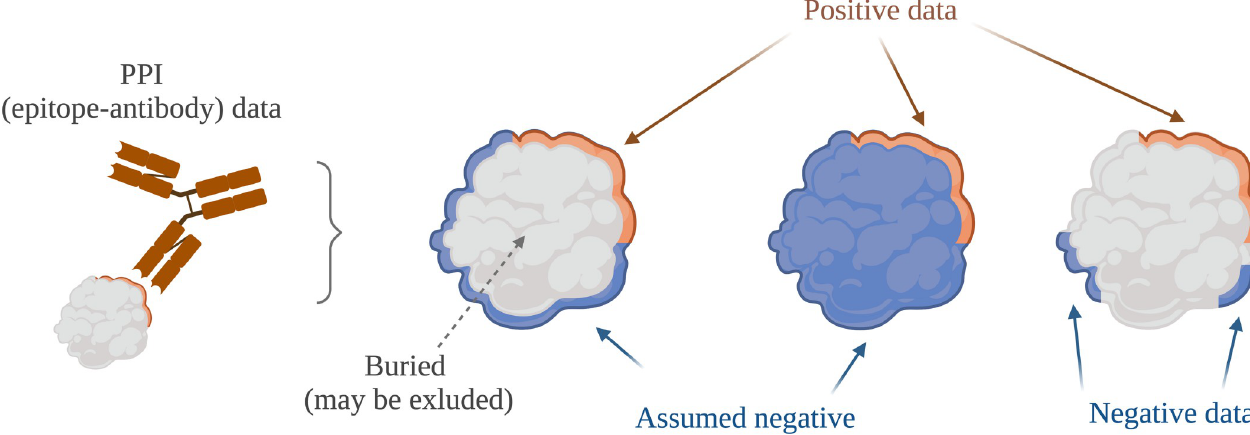
Fig 5. Defining positives and negatives in PPI interface data. A positive is a residue that was observed to be interacting, however, in general it is hard to obtain negative data for PPI. For epitope-antibody binding negative data may be available for some parts of the protein: peptides that were tested and shown to not bind. Buried residues may be considered negatives or you may prefer to exclude them altogether. Created with Biorender.com.